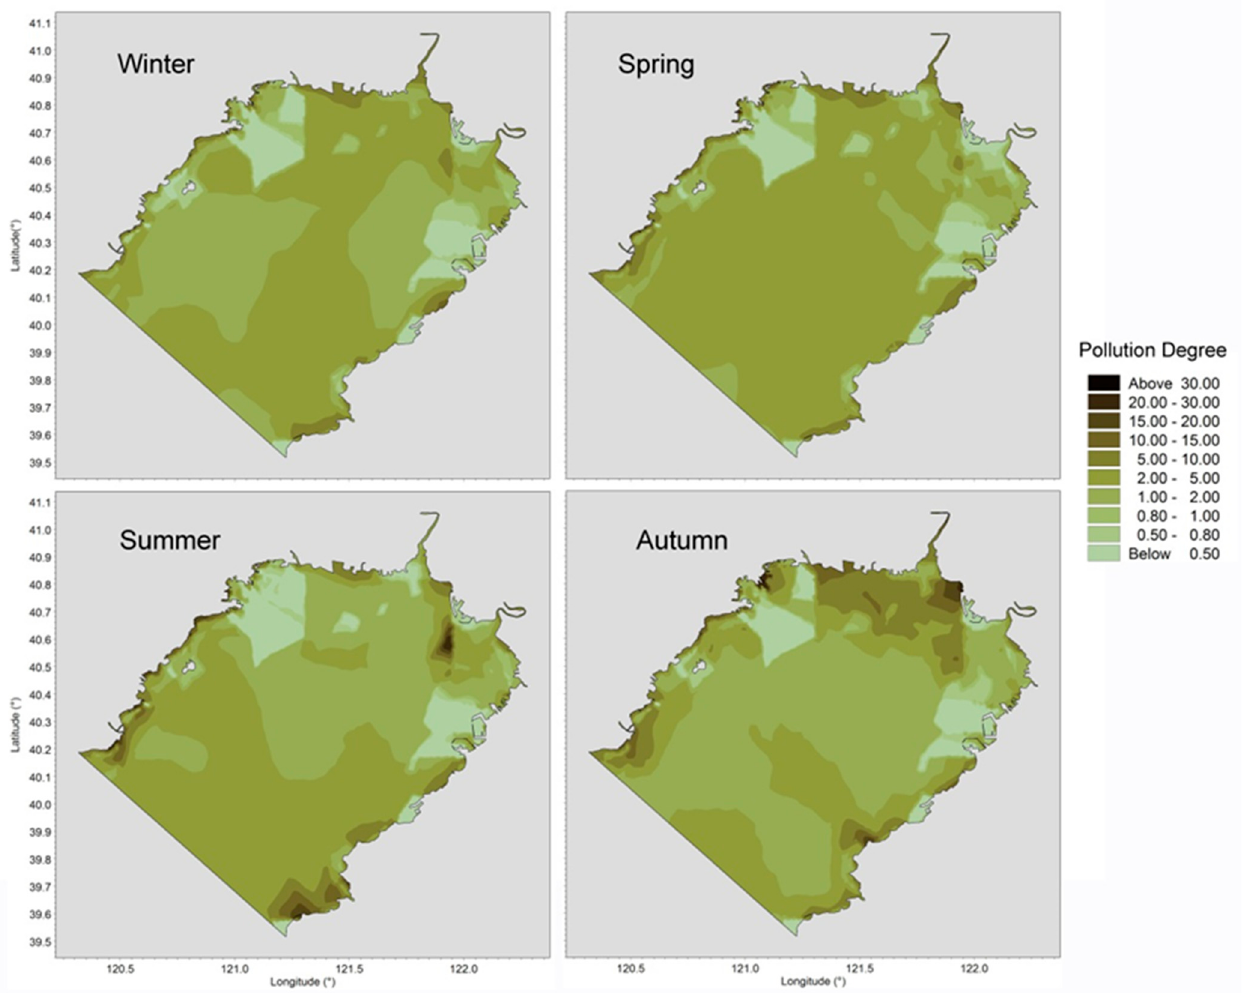
Figure 9. Horizontal distributions of dissolved heavy metal pollution degree in Liaodong Bay from